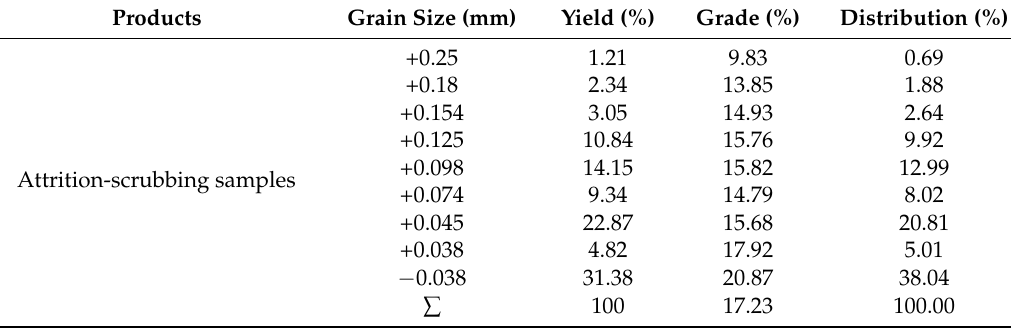
Table 6. Ilmenite distribution in attrition-scrubbing samples.